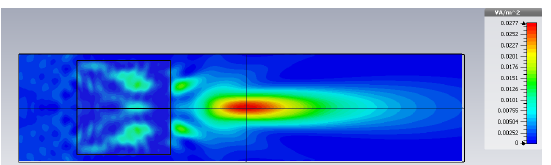
Fig.1. Example of near field intensity simulation for dielectric cuboid particle with dimensions of 4x4x4 in wavelength.